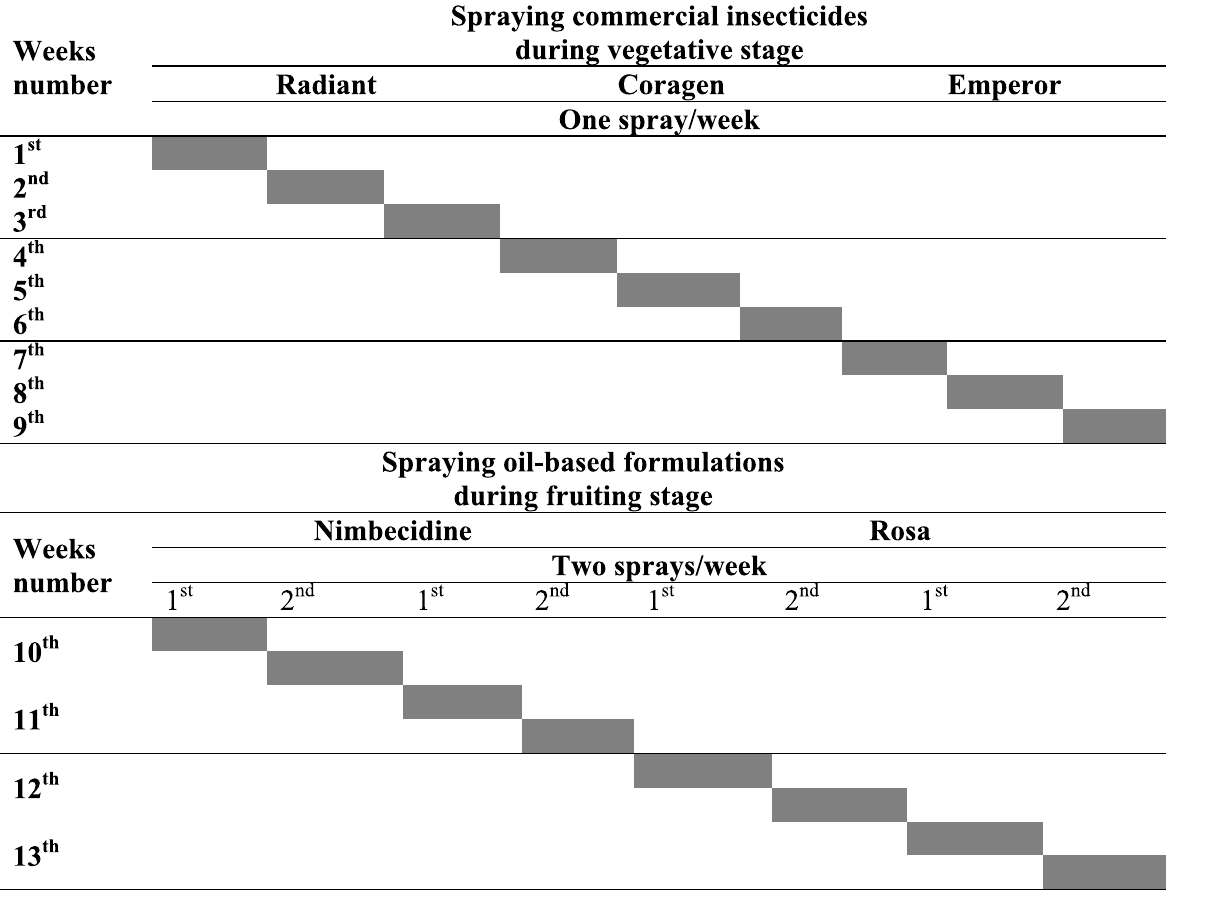
Table 2 Proposed sequences of the tested insecticides and naturally